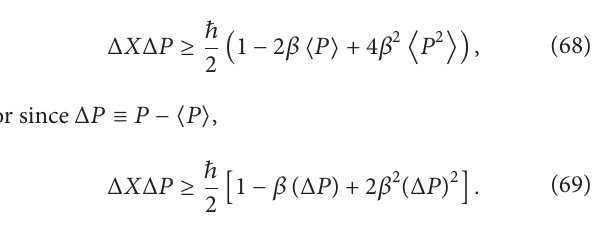
for different values of 𝛽 CORR